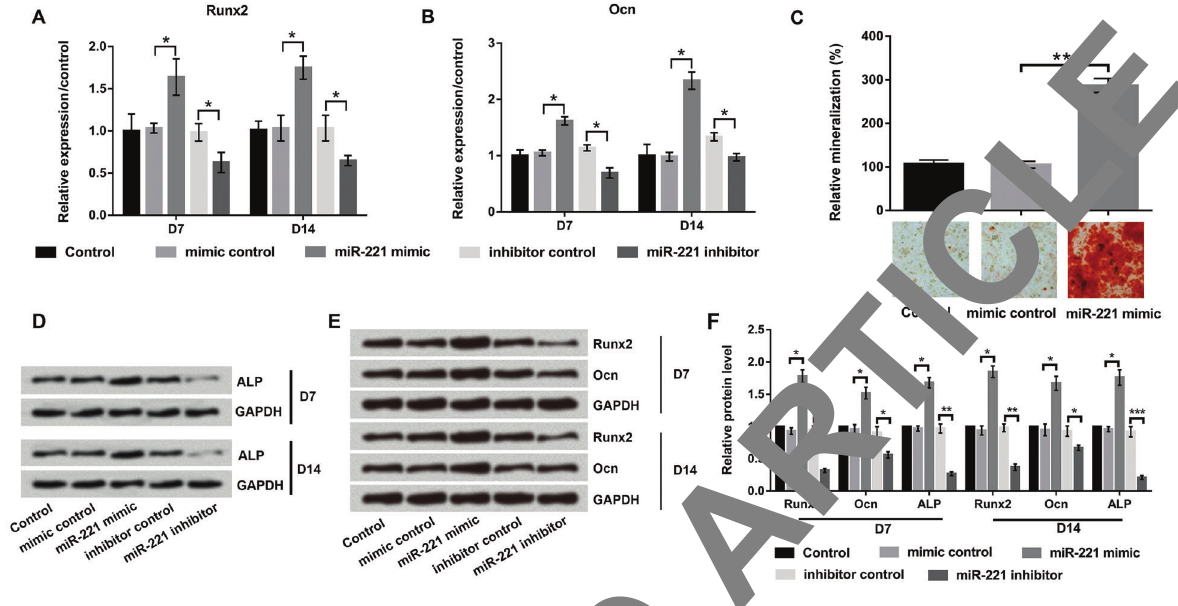
Figure 4. Overexpression of miR-221 promoted osteoblast differentiation. The mRNA expressions of ( A ) Runx2 and ( B ) Ocn were measured using qRT-PCR. C , The mineralized nodule formation in MC3T3-E1 cells with miR-221 overexpression was examined using the Alizarin Red S staining assay. D-F , Protein levels of ALP, Runx2, and Ocn were determined by western blot. miR-221: microRNA-221; ALP: alkaline phosphatase; Runx2: runt-related transcription factor 2; Ocn: osteocalcin; qRT-PCR: quantitative reverse transcription polymerase chain reaction. Data are reported as means ± SD.*P o 0.05, **P o 0.01, ***P o 0.001